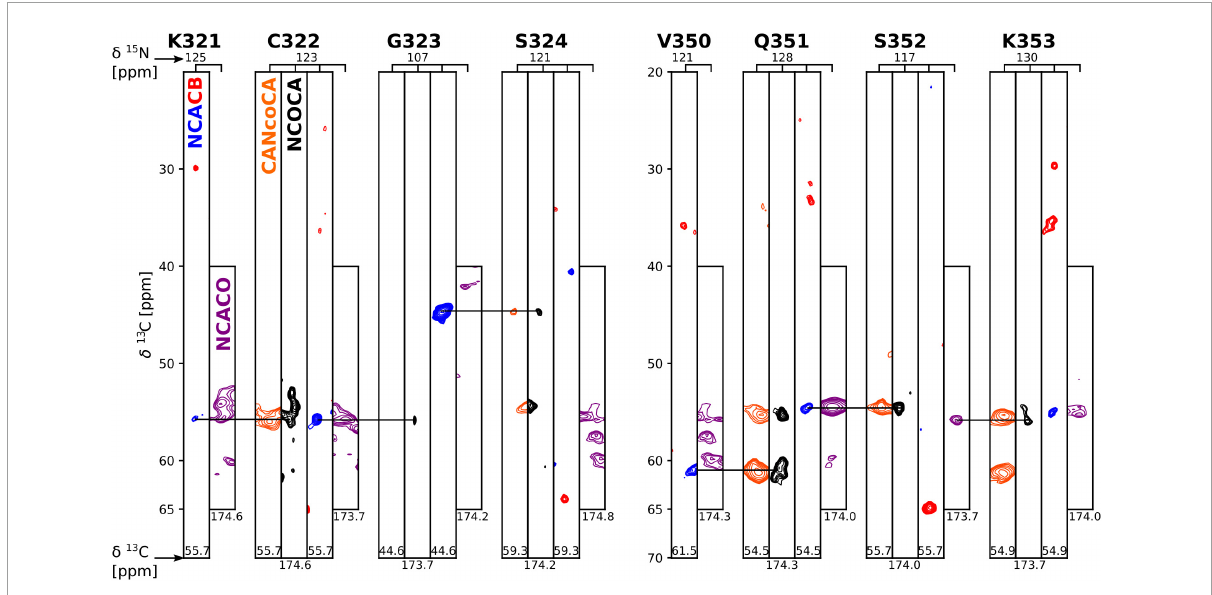
FIGURE3 Strip plot of 3D spectra used for resonance assignment. Strips through 3D CANcoCA (orange), NCOCA (black), NCACB (blue = positive; red = negative), and NCACO (purple) spectra. The 15 N shift and either CA or CO shift of each strip are indicated. Horizontal lines indicate the connectivities via common CA/CA-1 resonances.